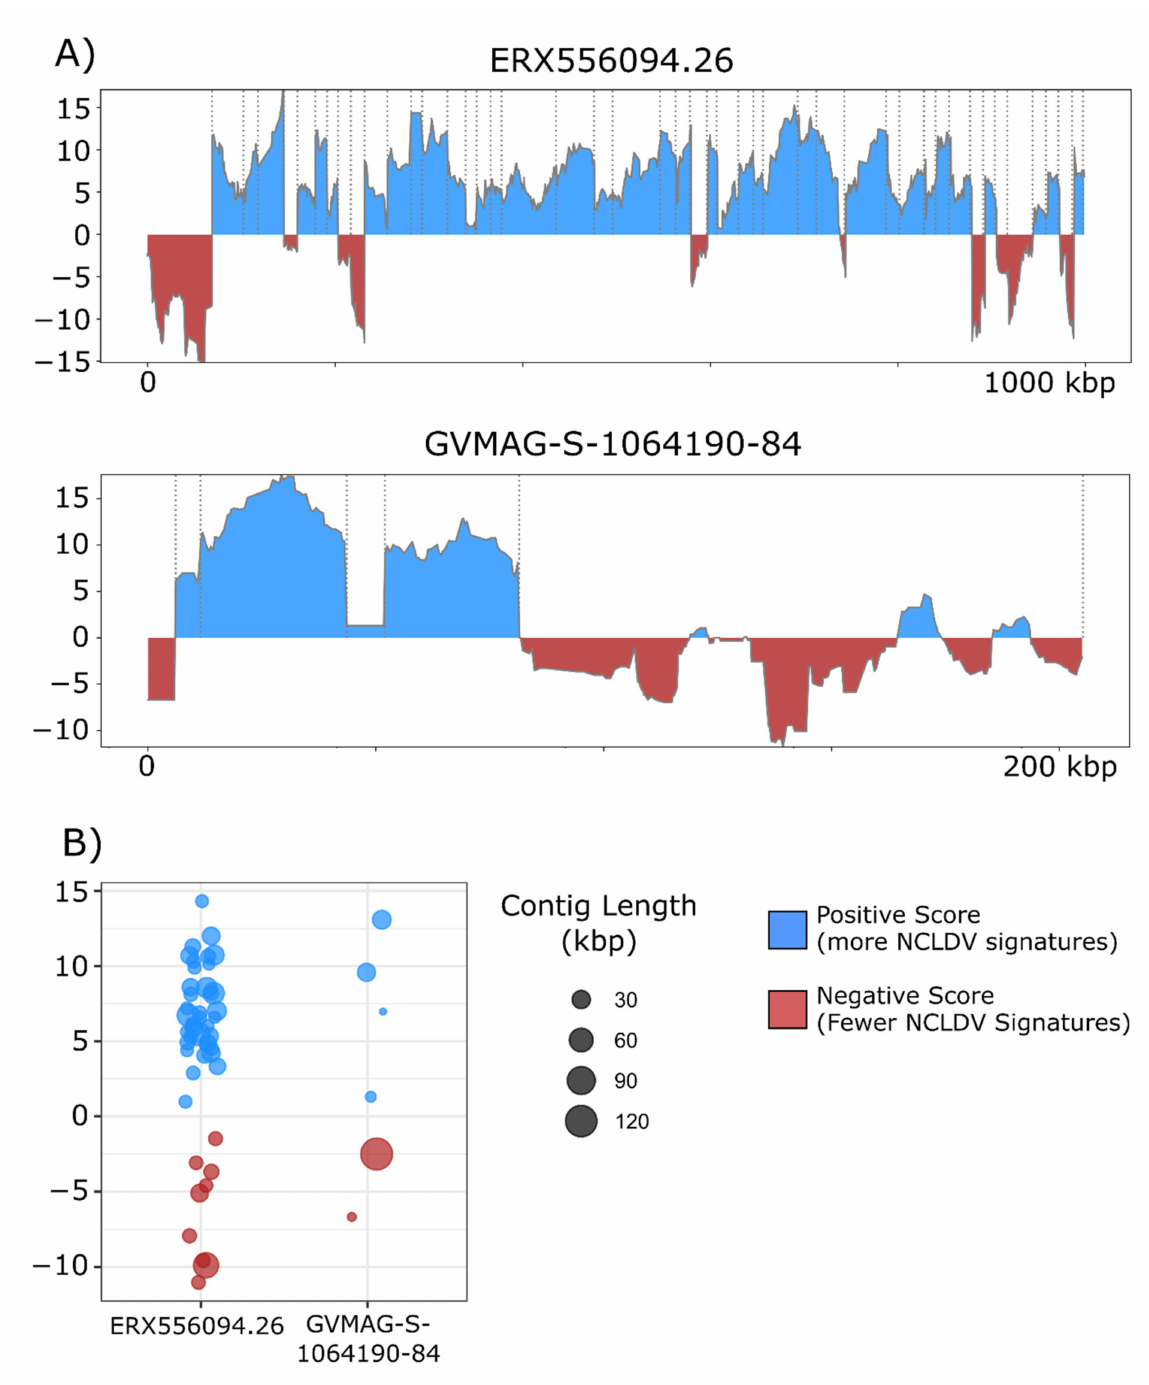
Figure 4. ( A ) ViralRecall plots for the giant virus MAGs ERX556094.26 and GVMAG-S-1064190.84 demonstrating that both contain non-NCLDV contamination. For ERX556096-26, nine contaminant contigs were detected, while two were found in GVMAG-S-1064190.84. ( B ) Dot plot of the mean ViralRecall scores for all contigs in ERX556094.26 and GVMAG-S-1064190.84. Contigs with ViralRecall scores < 0 are colored red, and dot sizes are proportional to contig